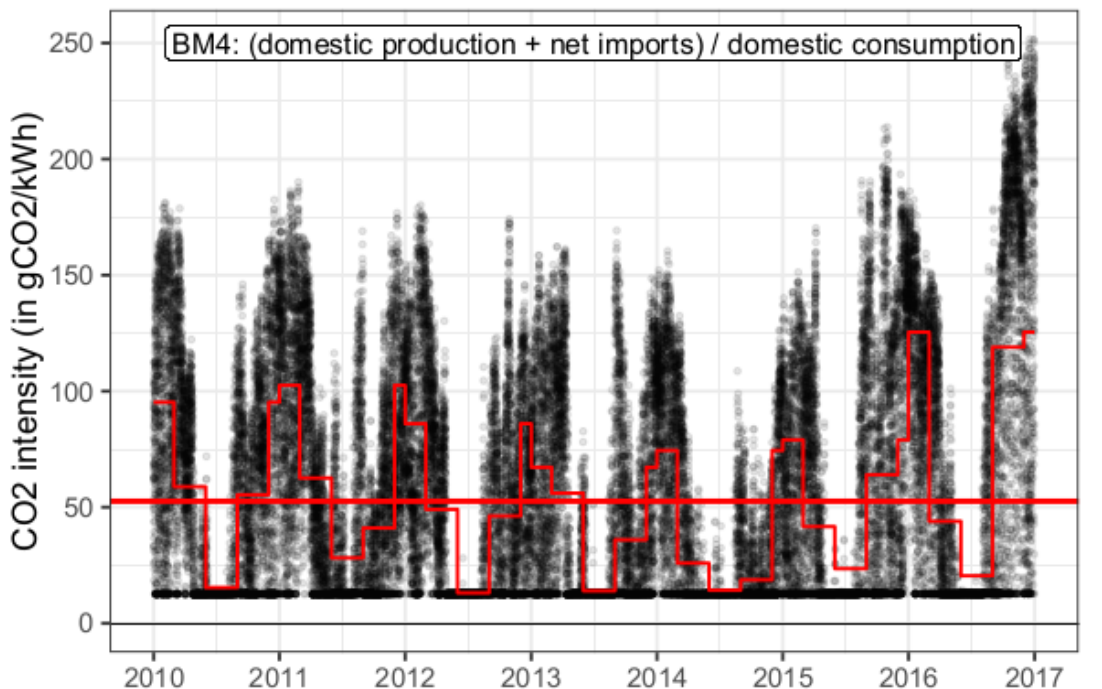
Figure 24. Hourly CO 2 intensities for the scenario “Status quo” for the years 2010 to 2016 calculated with balancing method “BM4”. Demand-weighted seasonal averages and the overall average at /kWh are indicated with red 53 g CO 2, eq